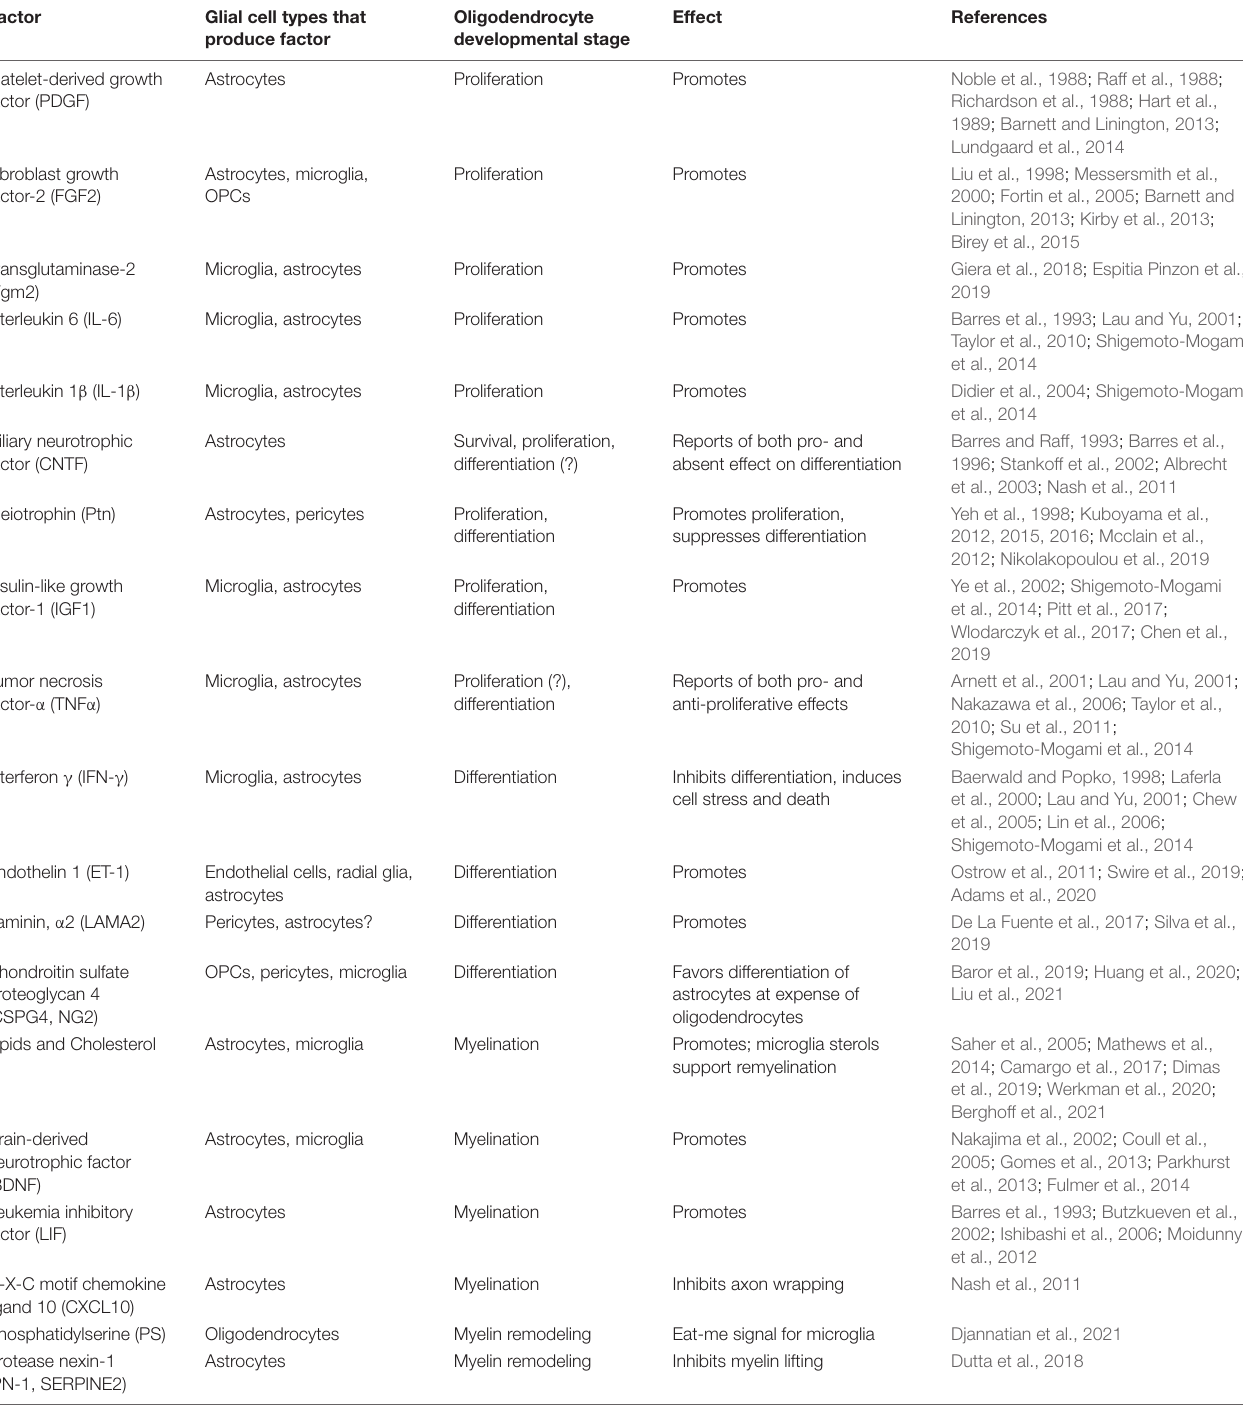
TABLE 1 | Glial secreted factors that shape oligodendrocyte